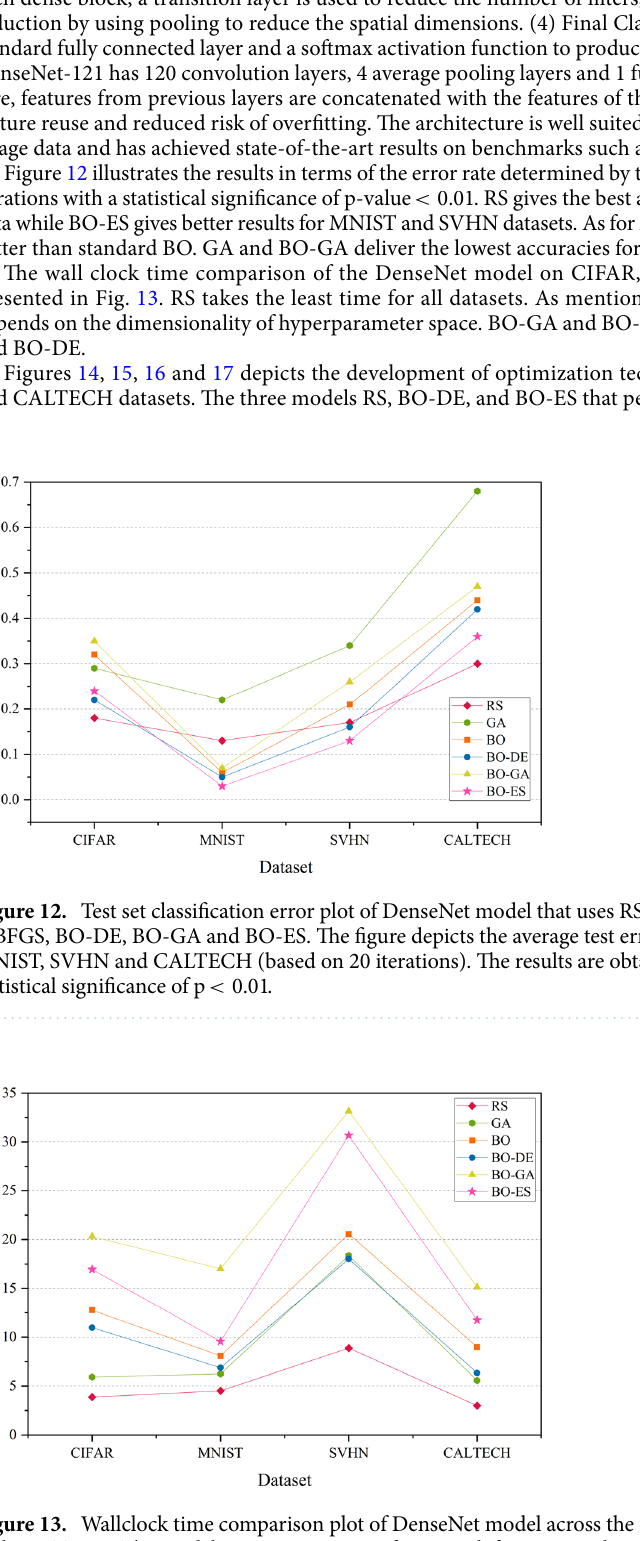
Figure 13. Wallclock time comparison plot of DenseNet model across the datasets—CIFAR, MNIST, SVHN and CALTECH. The model uses RS, GA, a BO framework for HPO with L-BFGS, BO-DE, BO-GA and